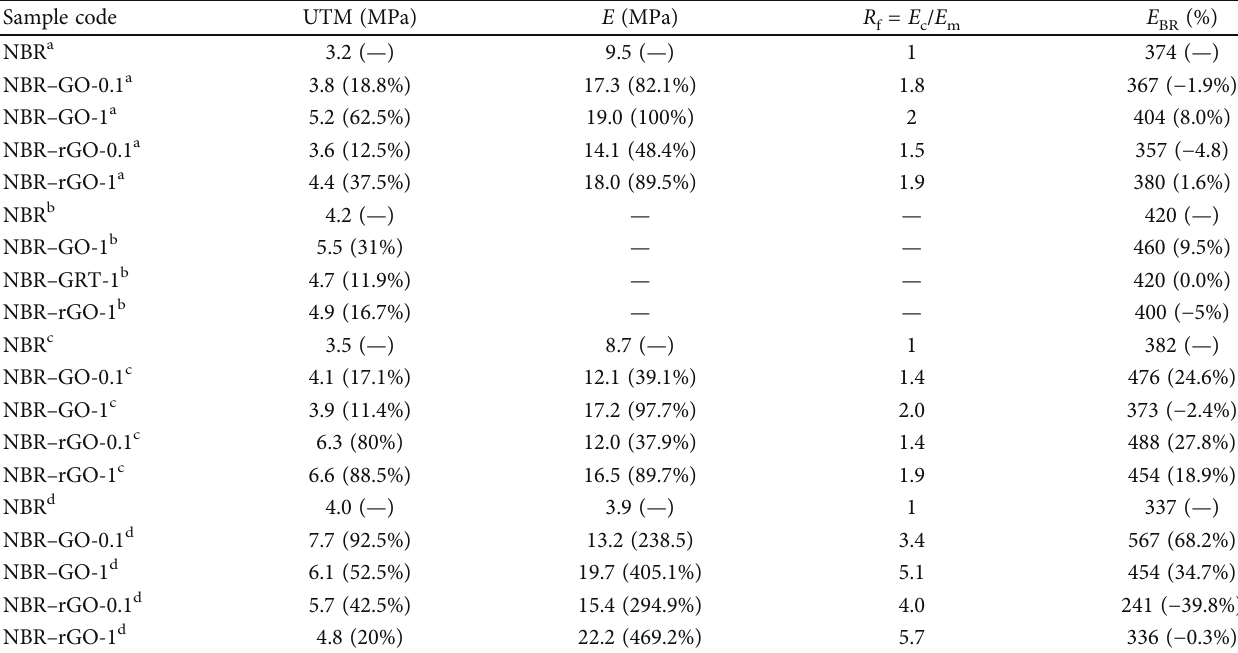
Table 6: Tensile properties of CZ-accelerated NBR – GDS